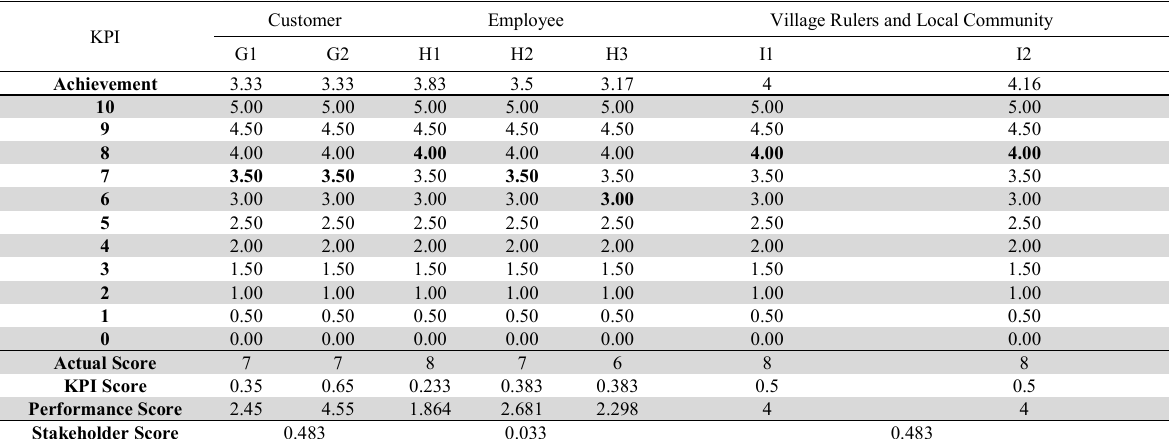
three green categories of KPIs, namely H1 KPI, I1 KPI and KPI 12. Besides, there are four KPIs in the Table 4 OMAX Table of Capability KPI Customer Employee KPI Achievement